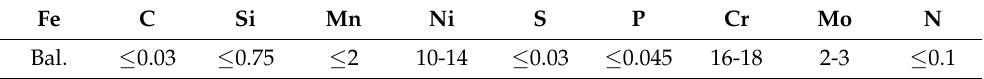
Table 1. Chemical composition of studied alloys,